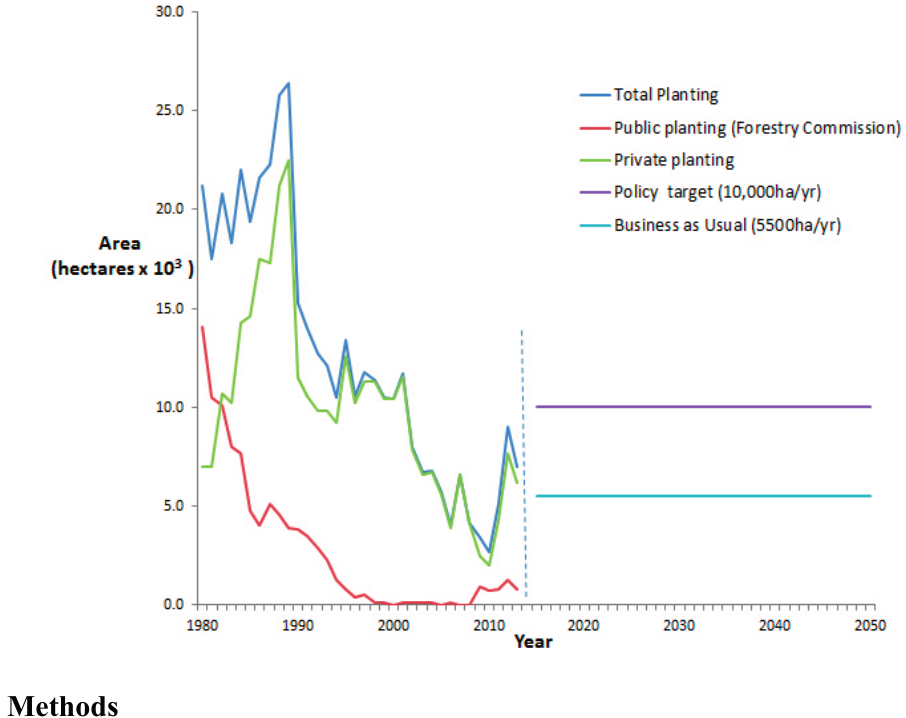
Figure 1. Recent woodland planting rates in Scotland [32] together with future